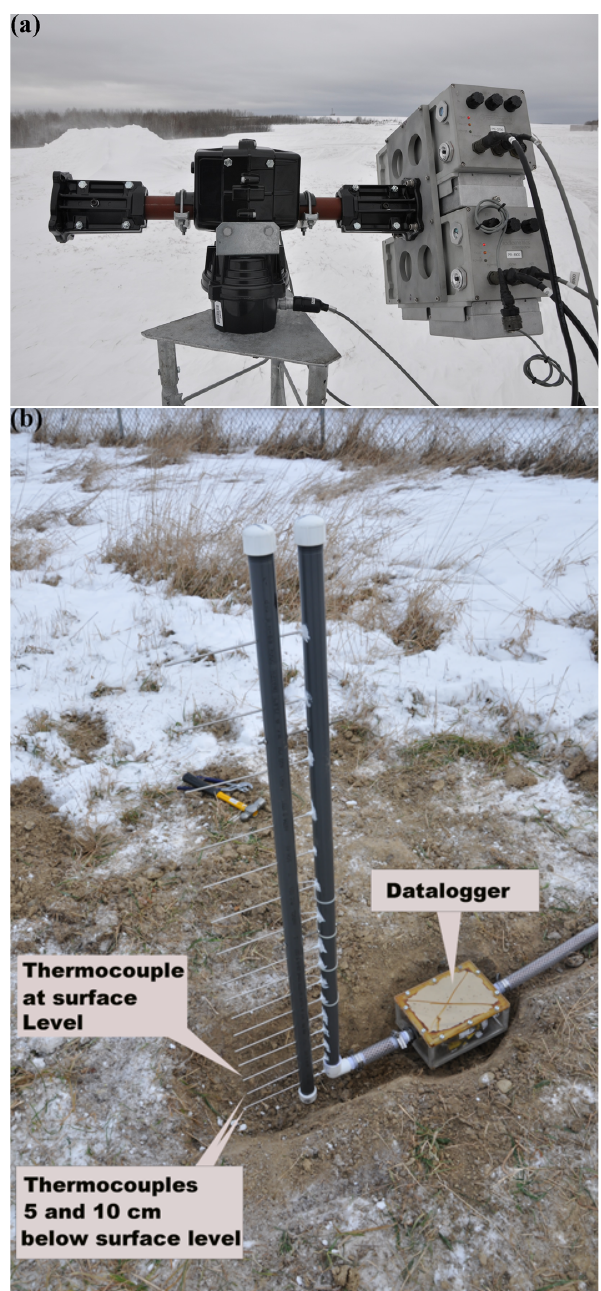
Fig. 2. (a) Microwave Radiometer (37 and 89GHz) attached to au- tomatic azimuth positioner. (b) Temperature profiler with 16 Wat- low Rigid Sheath Thermocouples to measure air/snow temperature at defined